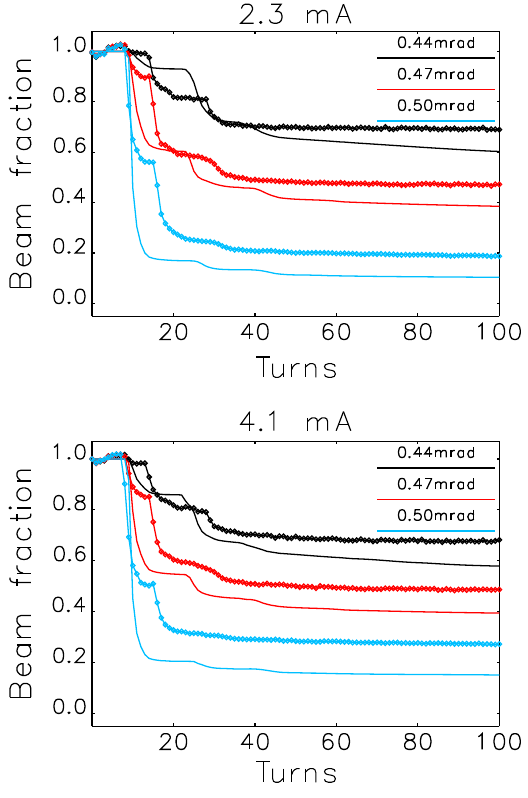
FIG. 7. Comparison of the turn-by-turn beam normalized bunch intensity for several kick amplitudes for a 2.3-mA bunch (top) and a 4.1-mA bunch (bottom). Lines show data from simulations, while connected points are from the experiments.